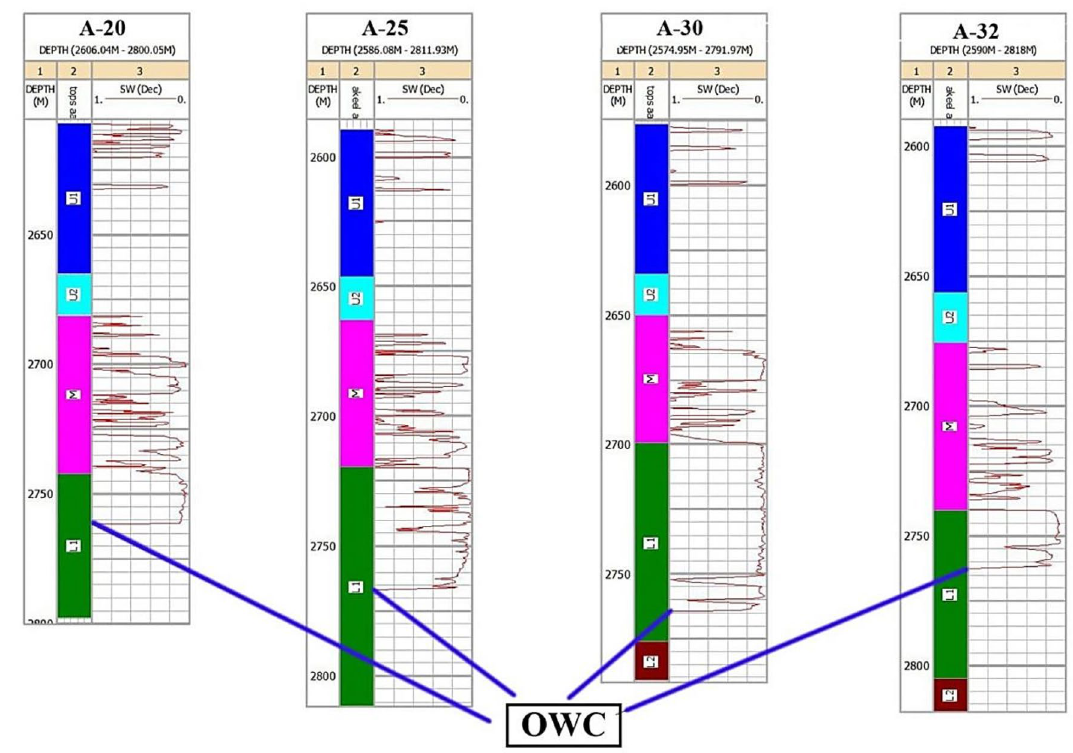
Fig. 9 The oil–water contact (OWC) determination based on estimating the water saturation (SW) based on the deep resistivity values, the SWM Oil